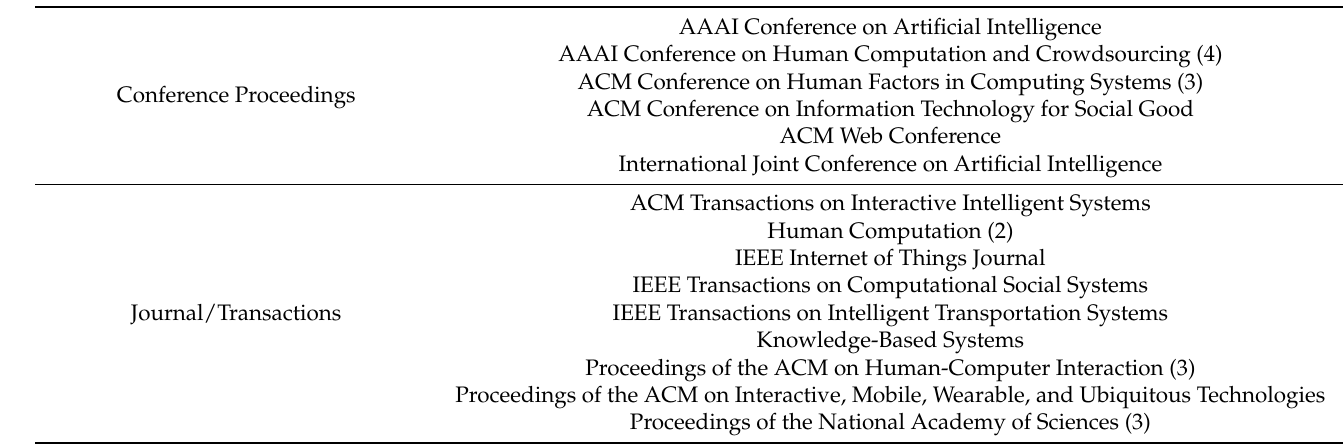
Table A2. Distribution of publications per